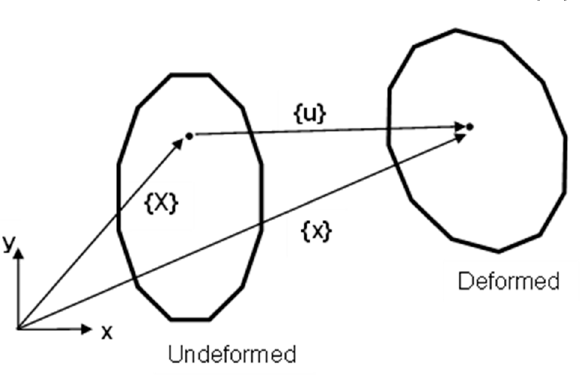
Figure 5. Calculation of the displacement vector for a geometrically nonlinear model.